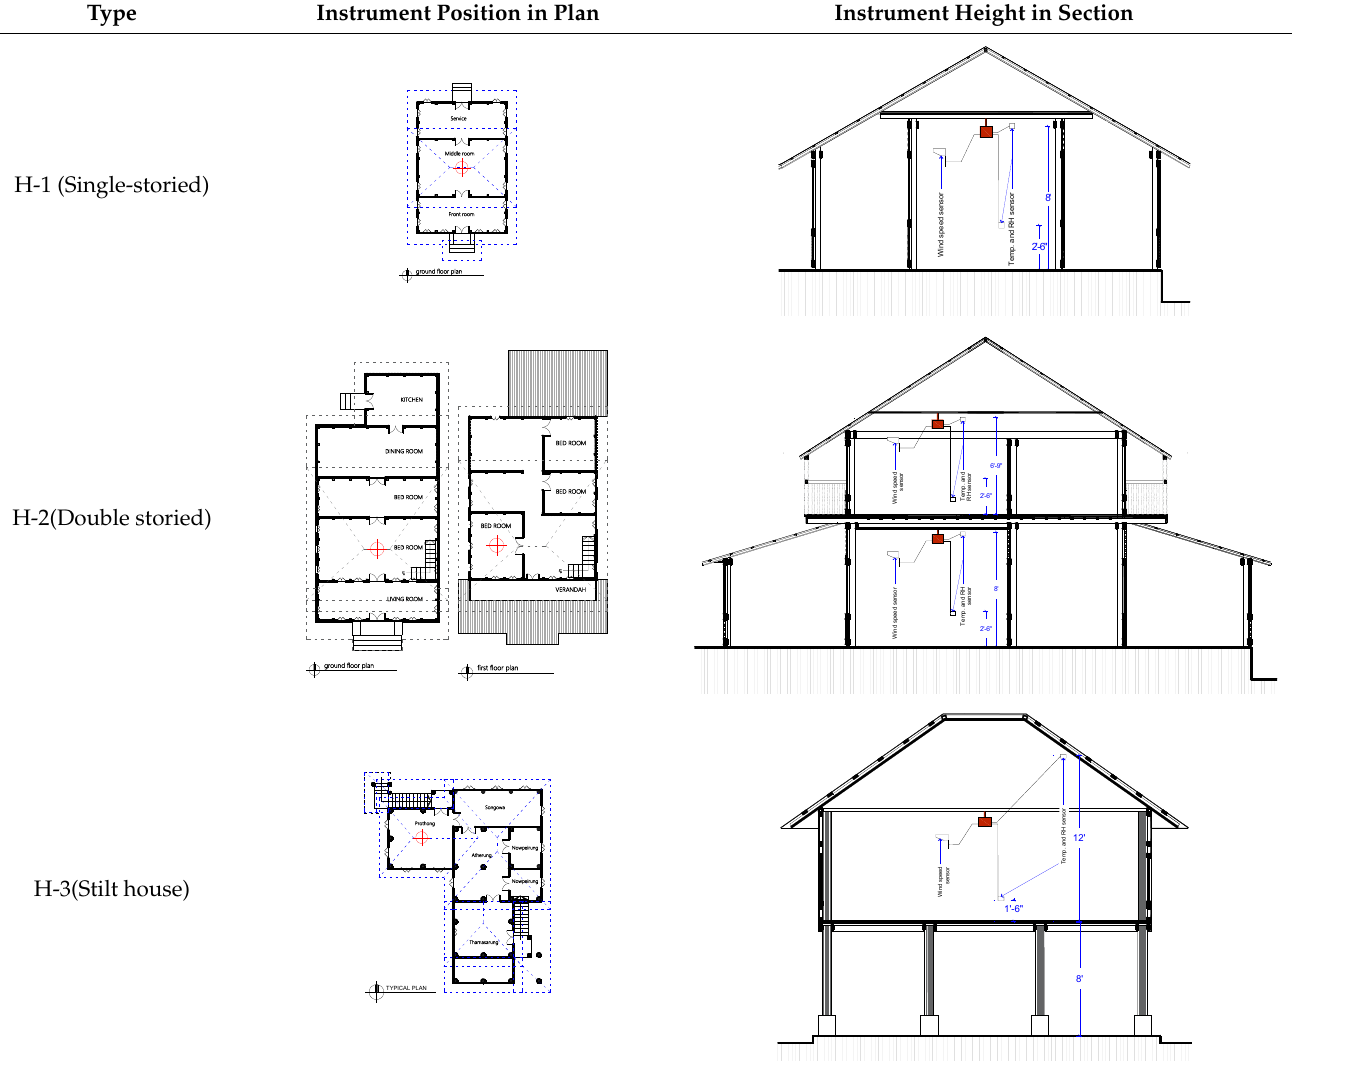
Table 2. Thermal properties of materials of traditional timber house.